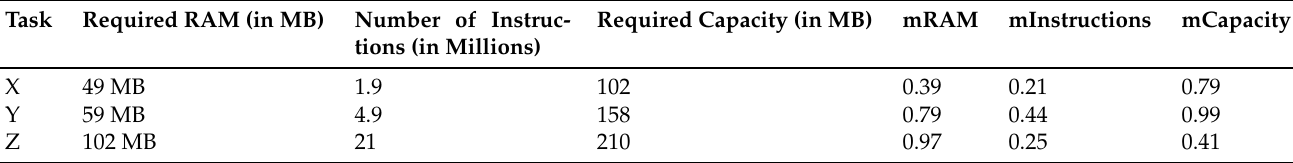
Table 5. Task Parameters(mParameter = Available − Value